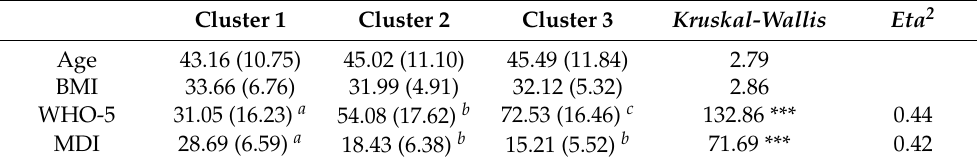
Table 6. Mean comparisons on the well-being, depression and sociodemographic data in the male